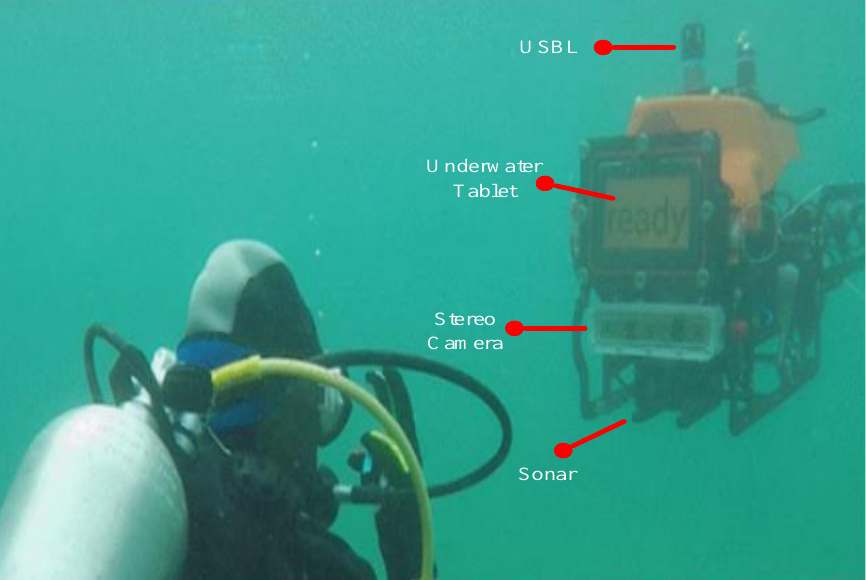
Figure 1. The CADDY system for assistance in diver missions as an example of U-HRI